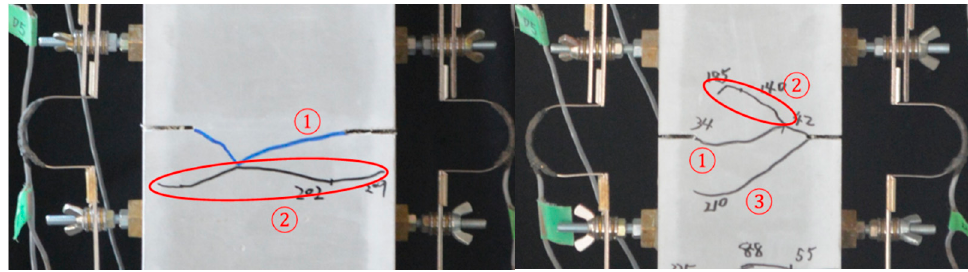
Figure 12. Examples of cracking process ( ① first crack, ② second crack, and ③ third crack).